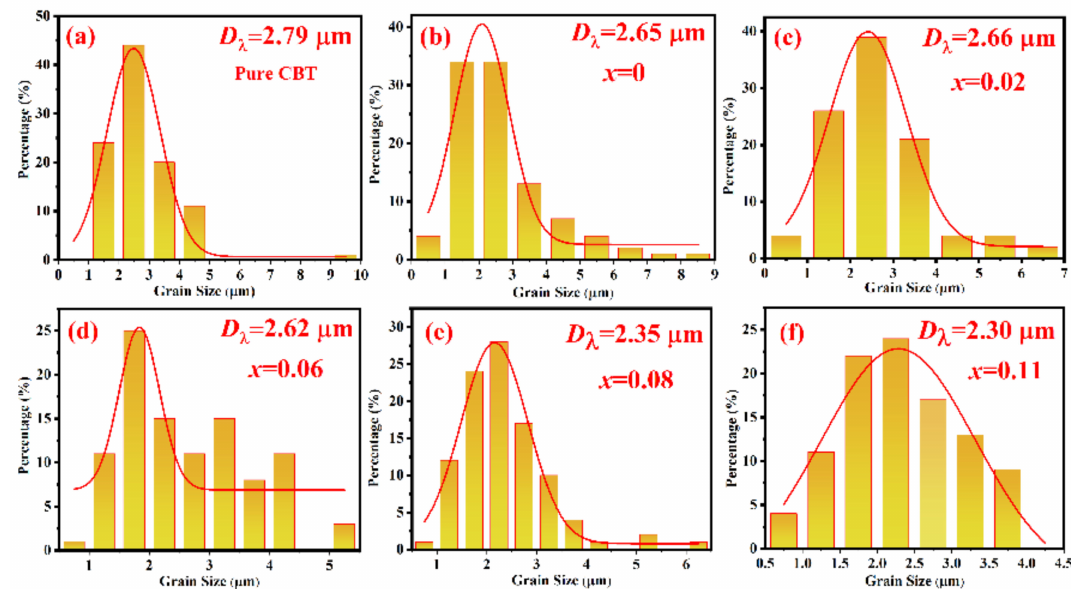
Figure 3. Grain size distribution of the CBT − x Gd/0.2Mn ceramics derived from SEM images.